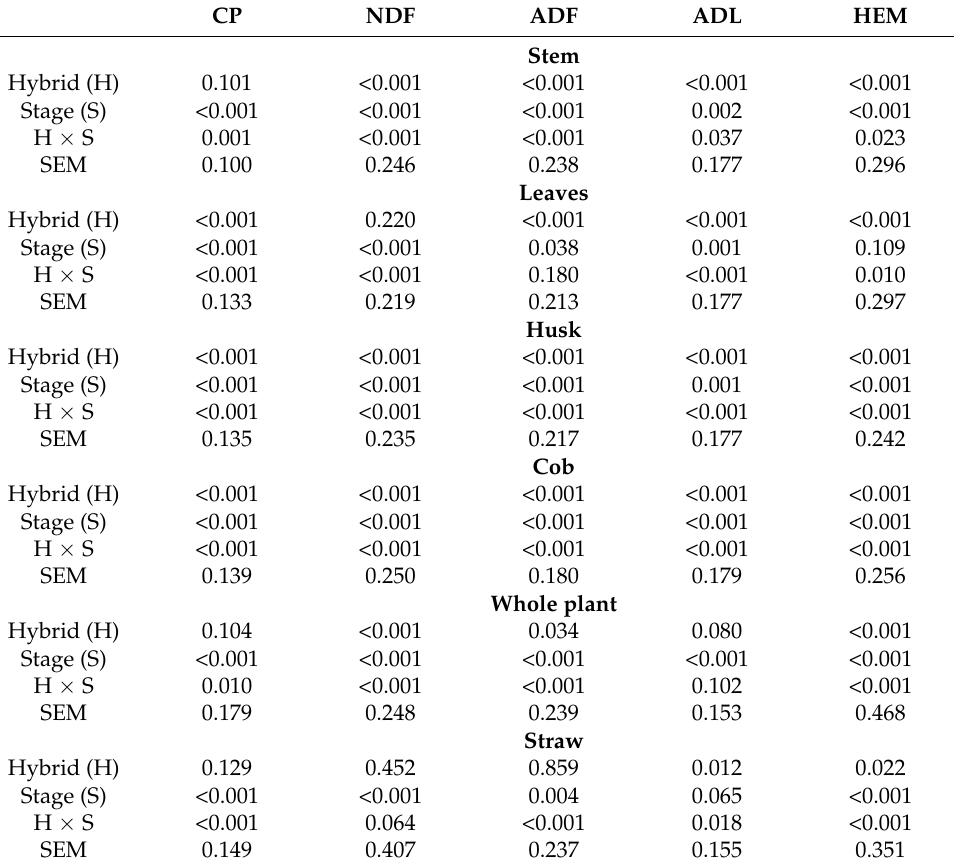
Table 1. Level of statistical significance ( p -values) of the effects of hybrid (H) and plant maturity stage at harvest (S) on the chemical composition of the whole plant and fractions of the maize